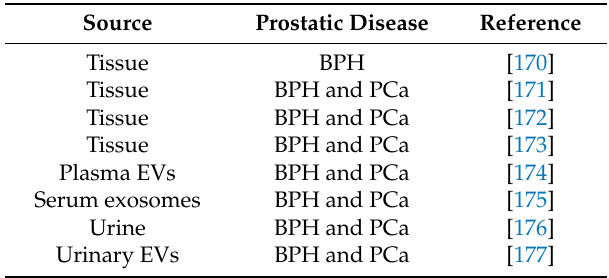
Table 1. Latest studies of miRNA expression profiles in different body samples derived from patients with BPH or